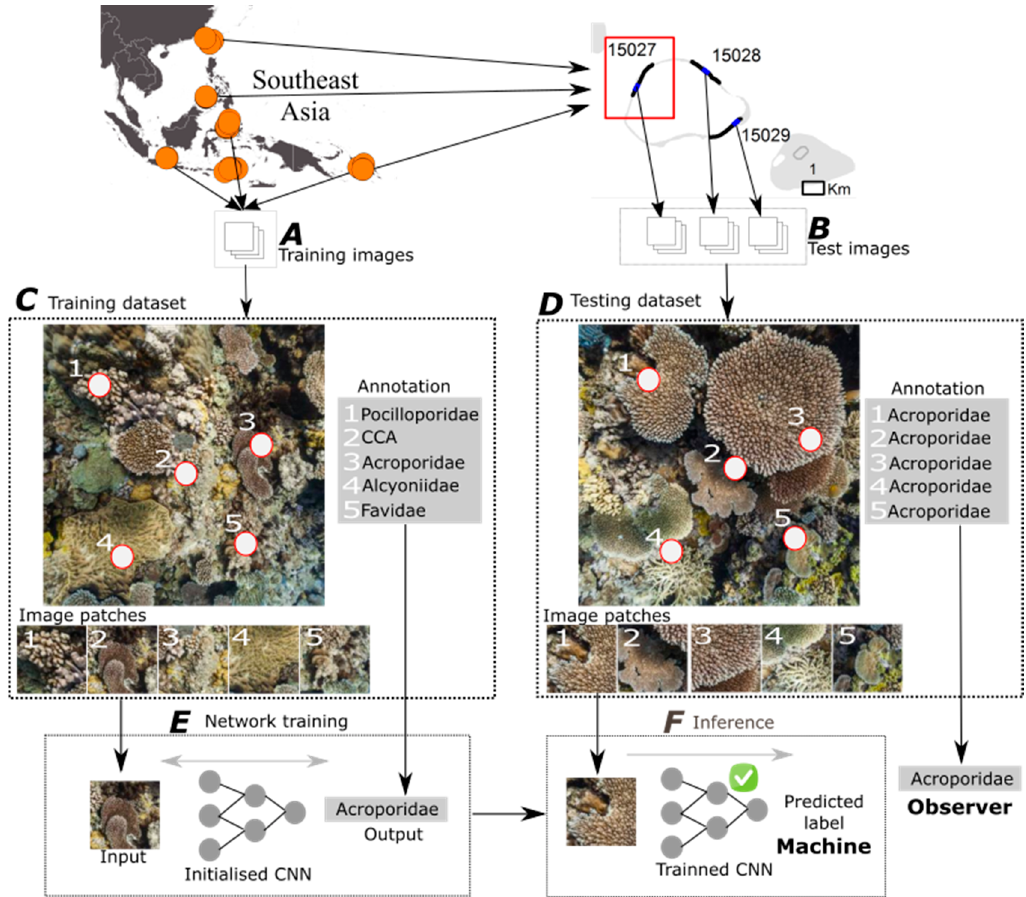
Figure 2. Methodological diagram to illustrate the workflow used in this study for training and testing Convolutional Neural Networks (CNN) for coral reef benthic monitoring. From a given region or country, images were selected in two groups: Training images (random selection) ( A ), and Test images (aggregated within test transects) ( B ). Both sets of images were manually annotated using the random point count methodology to create a training dataset ( C ) and test dataset ( D ). Datasets were comprised by cropped patches from each random point in an image (image patches) and labels assigned to each patch (annotations). To train the network, we used an initialised CNN (VGG16) finetuned through backpropagation on the training set ( E ). The fully trained network was then used to classify the test images (Inference) ( F ), and contrast the predicted labels (i.e., Machine) against the observed annotations (i.e., observer) in the test dataset.